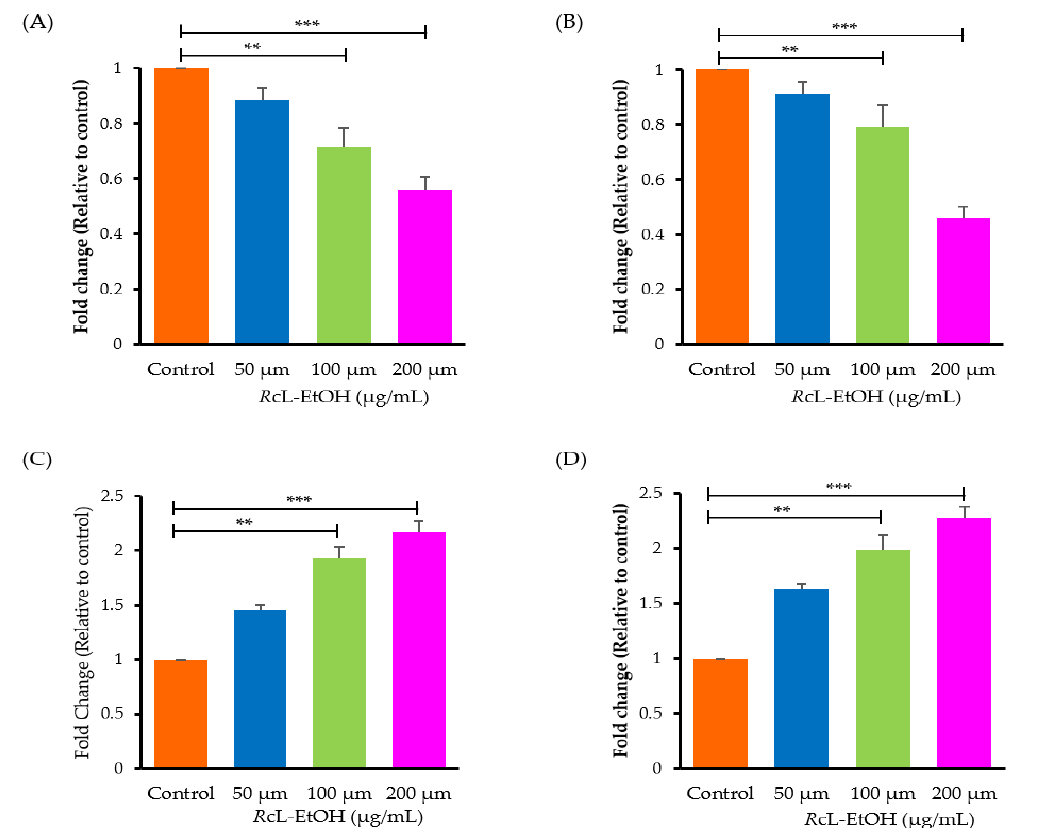
Figure 6. Changes within the mRNA expression of anti-apoptotic genes; ( A ) Bcl2; ( B ) BCl XL and pro-apoptotic genes; ( C ) Bax; ( D ) Bad. ** p < 0.01 and *** p < 0.001 vs. control.